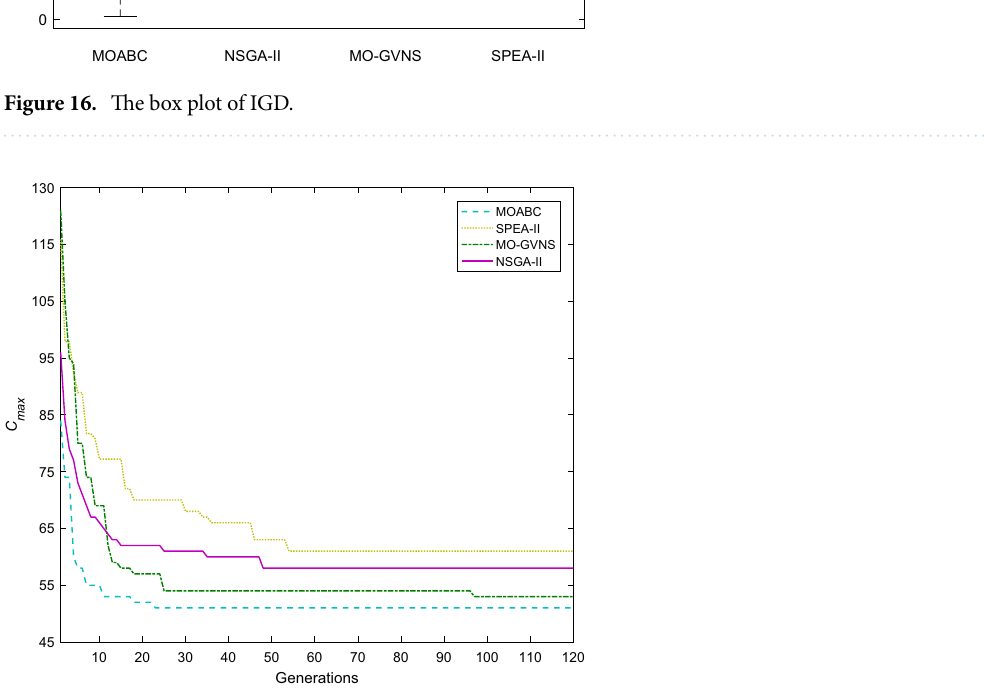
Figure 17. Convergence diagram of instance f2j15s3r1 about